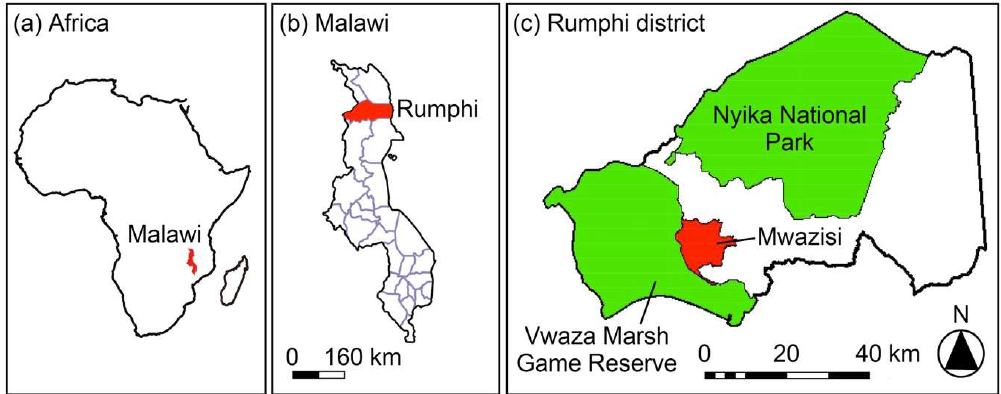
Figure 1. Location of the study area.